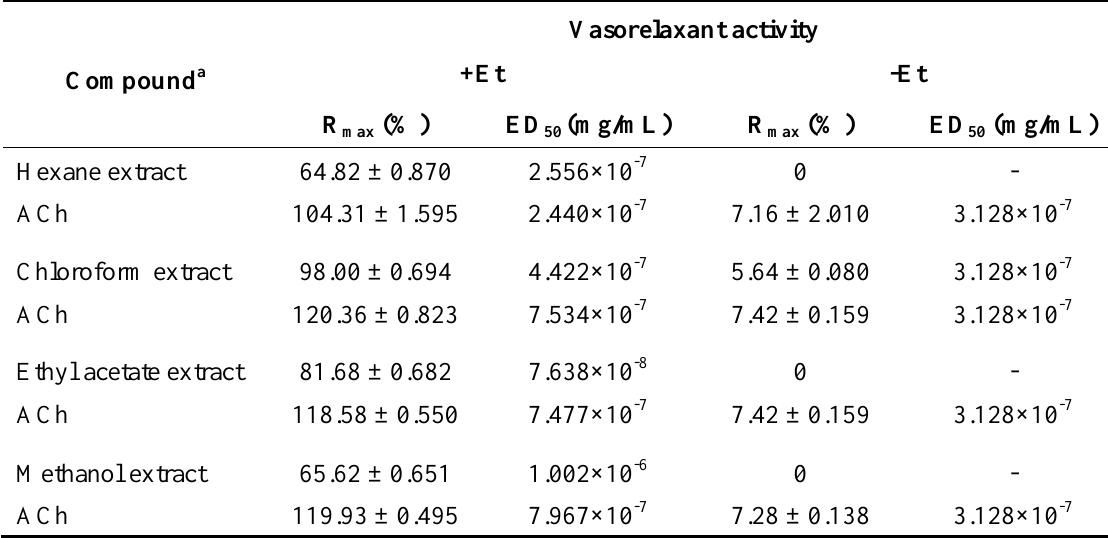
Table 3. Effect of endothelial cells on vasorelaxant activity of Spilanthes acmella Murr.